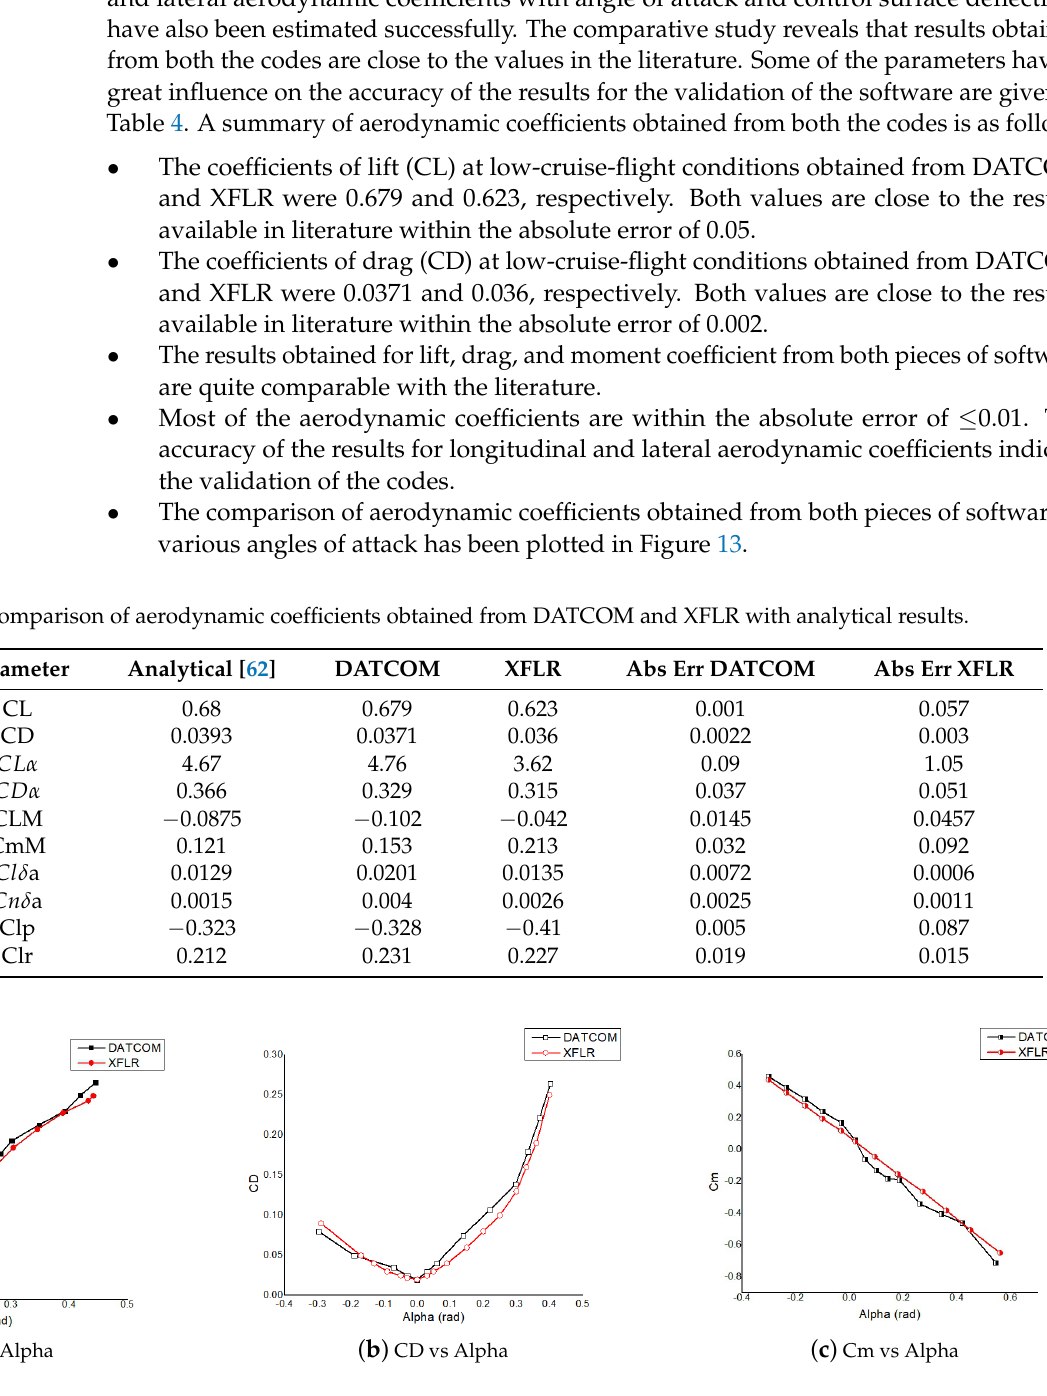
Figure 13. Comparison of aerodynamic coefficients ( a ) Variation of lift coefficient (CL) with angle of attack. ( b ) Variation of drag coefficient (CD) with angle of attack ( c ) Variation of moment coefficient (Cm) with angle of attack. The obtained results are having same trends as well as close values. Comparison of results obtained from DATCOM and XFLR software shows accuracy of the source